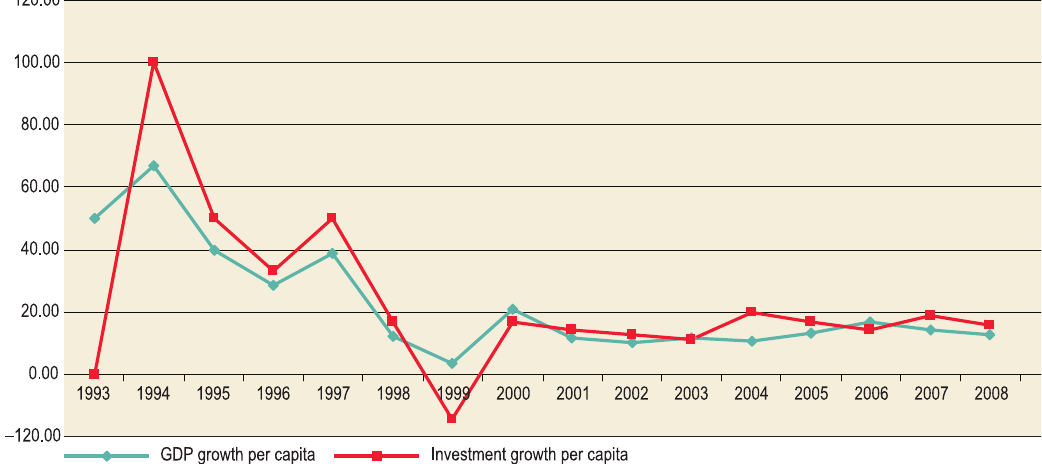
Fig. 3. GDP and investment per capita growth, % (source: EUROSTAT, ratios calculated by the authors)